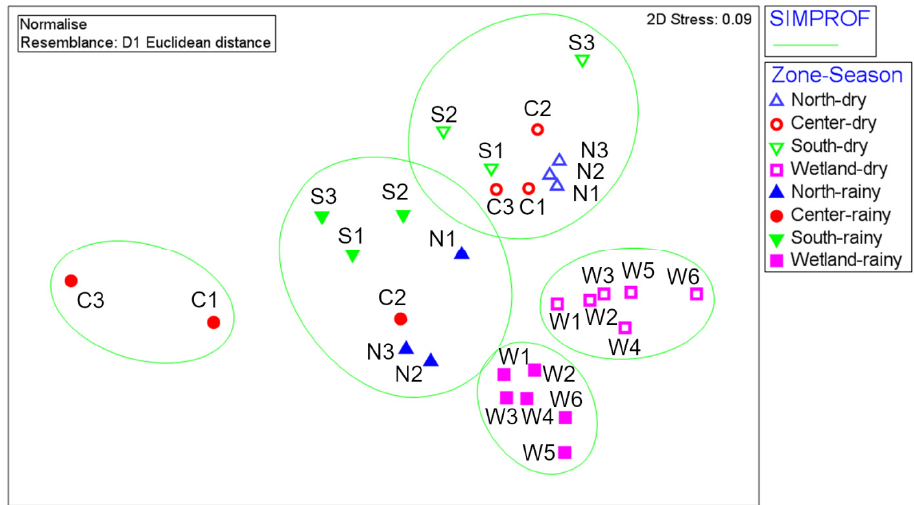
Figure 4. Non-metric multidimensional scaling (nMDS) projecting the Euclidean distances between the 30 normalized samples from La Sabana with a bidimensional stress of 0.09. The ellipses mark significant groups identified by SIMPROF. Symbols identify each lake zone ( ▲ North, ● Center, ▼ South, ■ Wetland), with dry season samples represented by unfilled symbols and rainy season samples represented by filled ones. Labels identify the number of samples from each lake zone and season.